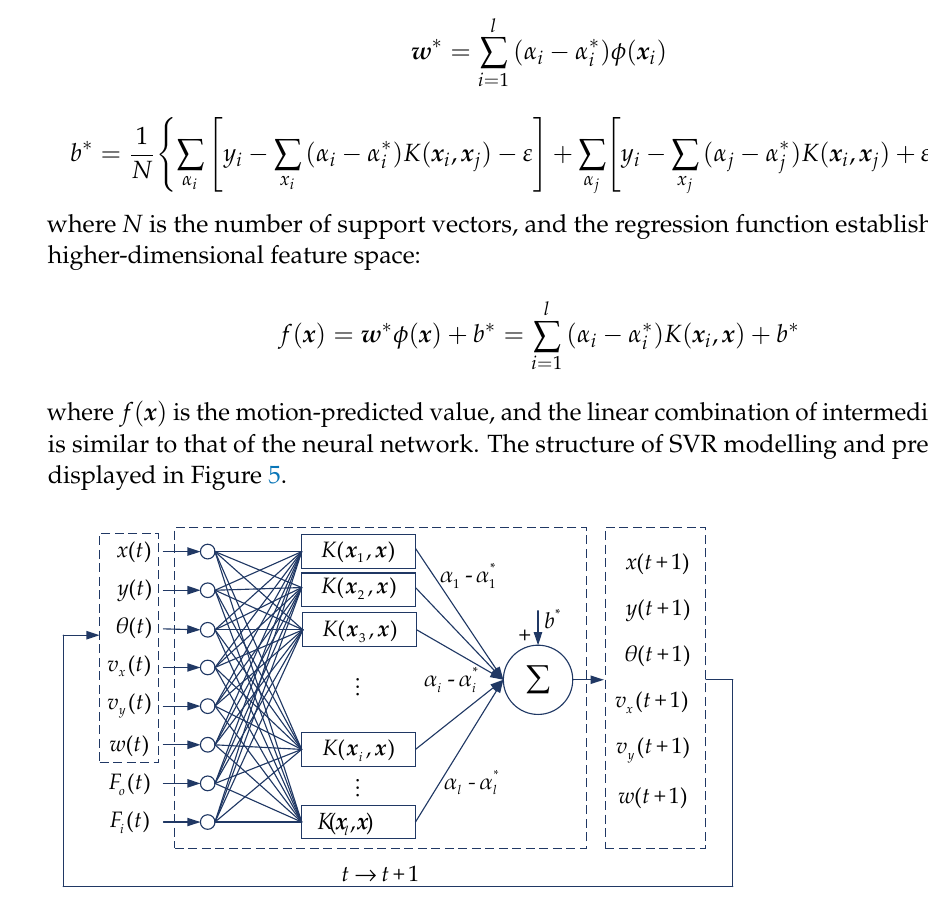
Figure 5. Structure of SVR modelling and prediction.